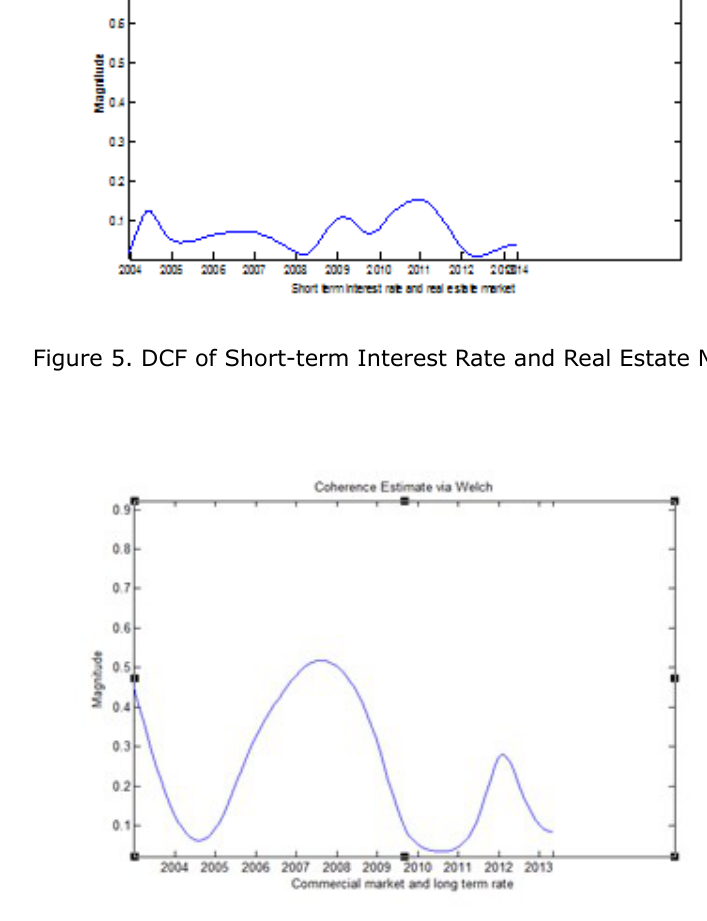
Figure 6. DCF of Long-term Interest Rate and Real Estate Market